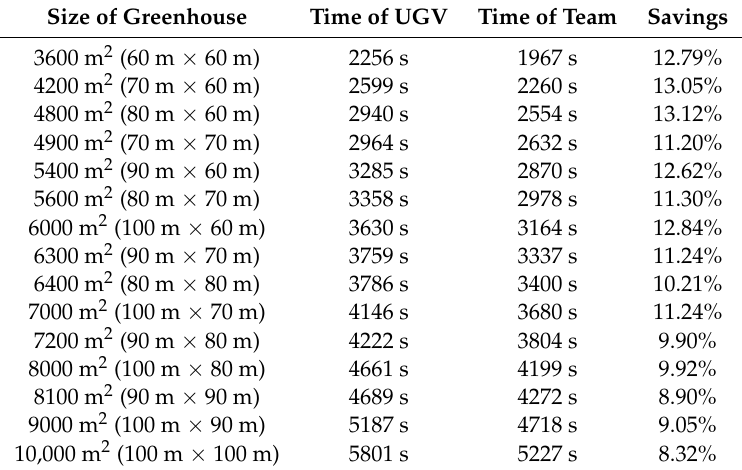
Table 5. Measurement frequencies according to greenhouse sizes. Size of Greenhouse Time of